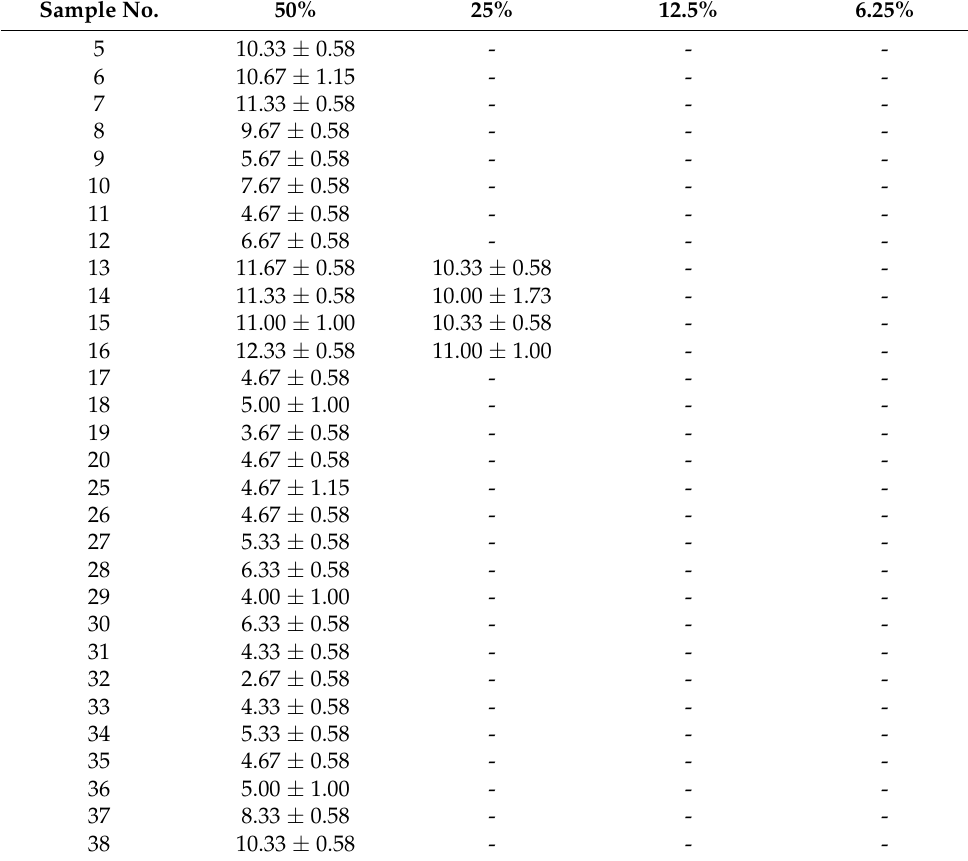
Table 5. Antimicrobial activity of samples against E. faecalis in mm. Sample